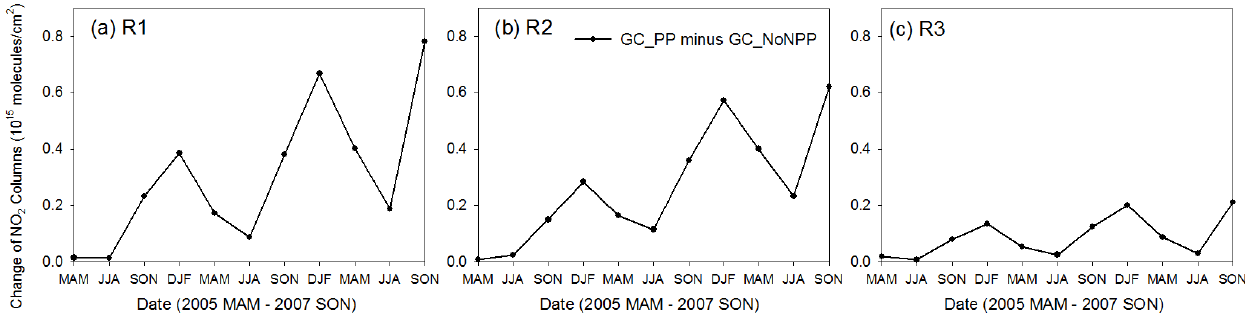
Fig. 13. Seasonal evolution of NO 2 columns from the new power plants, defined as the absolute differences between GC PP and GC NoNPP, during 2005 MAM to 2007 SON in the three regions in Fig.